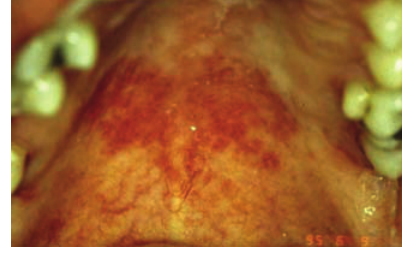
2005;13:143-8.Figure 2. Erythematous candidiasis. 8 Reproduced with permission from IAS- USA. Top HIV Med